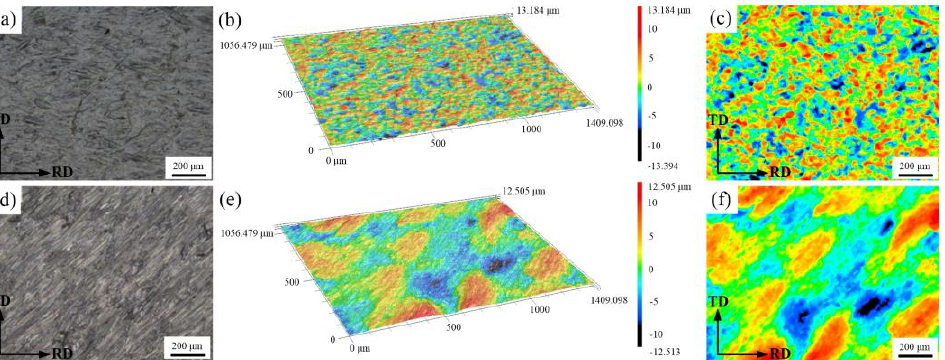
Figure 1. Topography and three-dimensional profiles of Mg and Al sheets after grinding with a wire